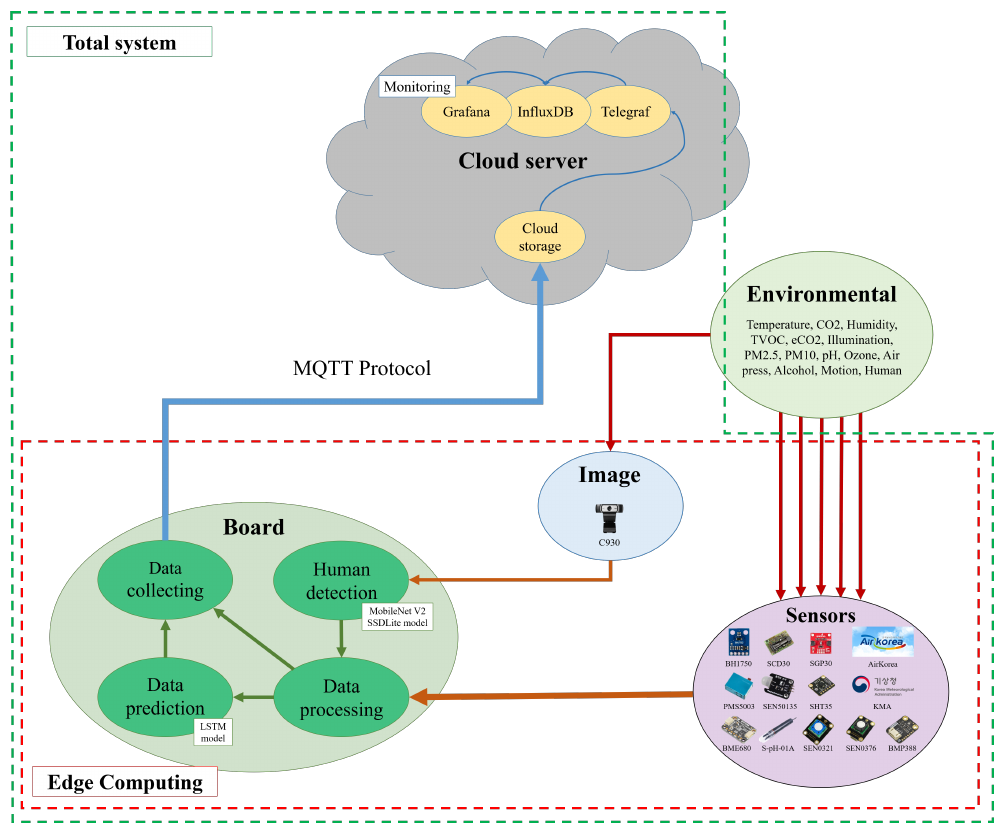
Figure 5. Structure of indoor multi-environment sensor system based on intelligent edge